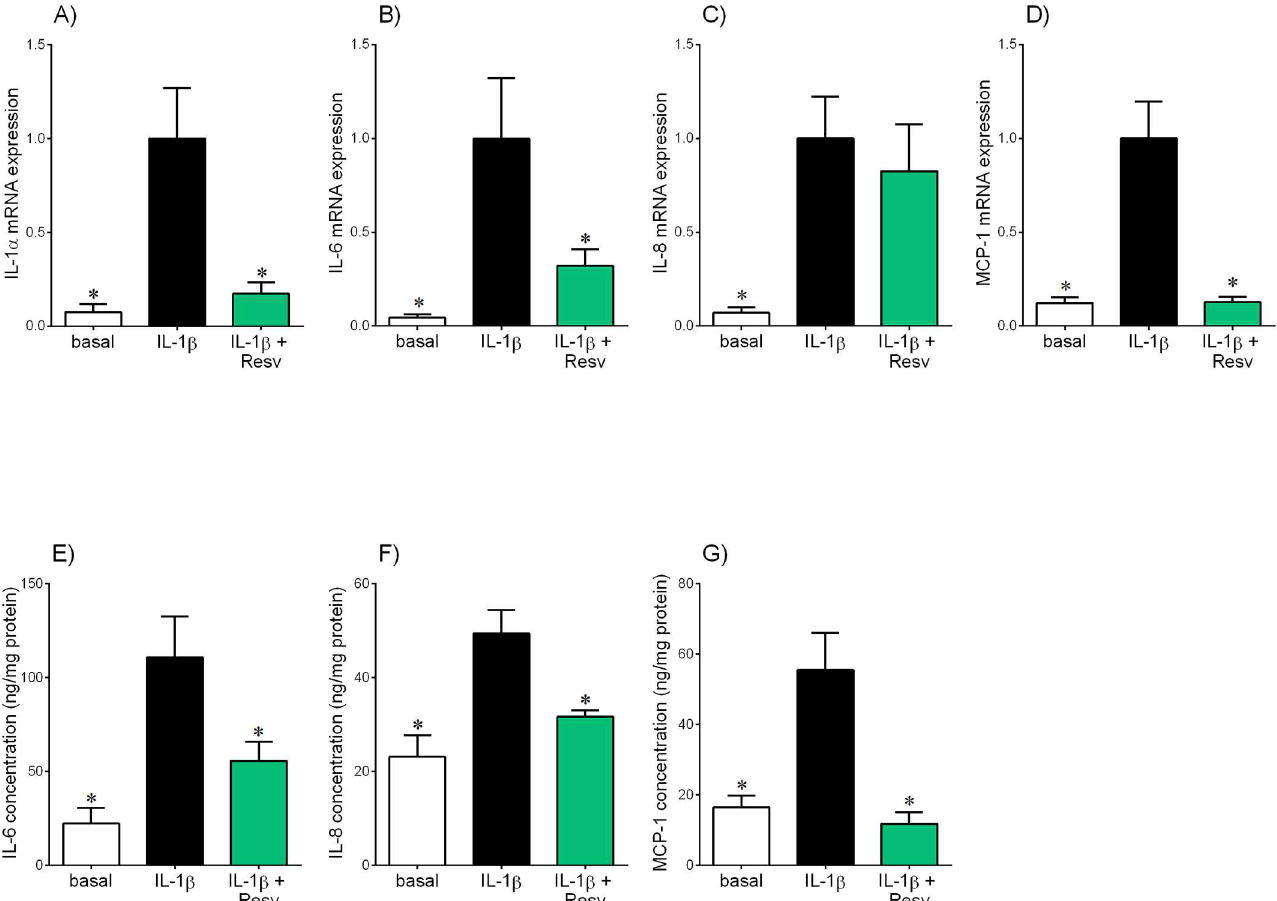
Fig 5. Effect of resveratrol on IL-1 β -induced pro-inflammatory cytokines and chemokines in in omental adipose tissue. Human omental adiposetissue was incubatedwith 5 ng/ml IL-1 β in the absenceor presenceof 200 μ M resveratrol (resv) for 20 h (n = 6 patients). (A-D) IL-1 α ,IL-6, IL- 8 and MCP-1 mRNA expressionwas analysedby qRT-PCR and the fold changewas calculatedrelative to IL-1 β . (E-G) The incubationmedium was assayed for concentration of IL-6, IL-8 and MCP-1 release by ELISA. All data are displayedas mean ± SEM. * P < 0.05vs. IL-1 β